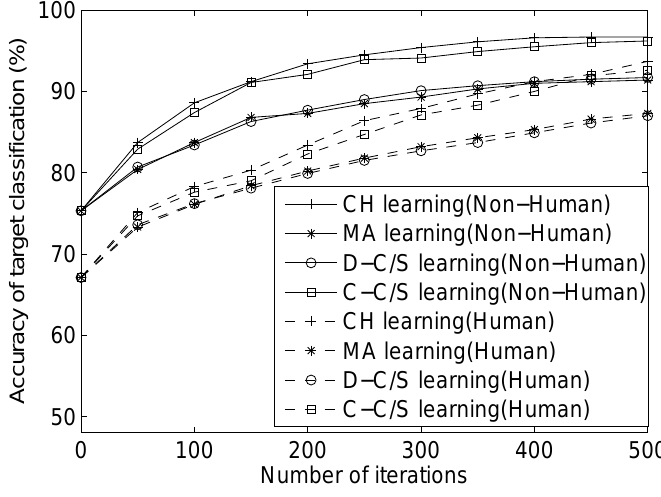
Figure 13. The classification accuracy of human target and non-human target with different number of iterations in four different learning